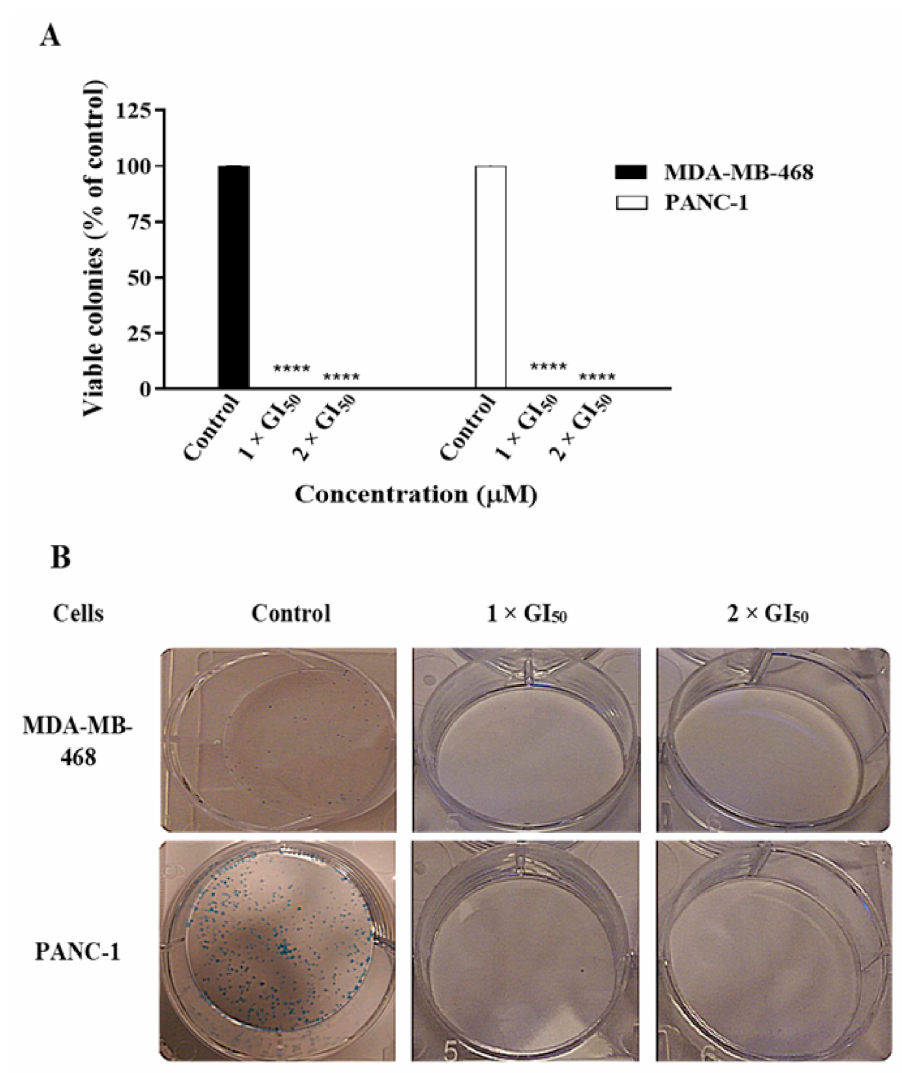
Figure 3. ( A ) Compound 19 completely inhibited the formation of colonies by MDA-MB-468 and PANC-1 cells after 24 h of treatment at concentrations of 1 × GI 50 and 2 × GI 50 . The assay was repeated at least three times. Bars and error bars refer to the mean ± SD. **** p < 0.0001 vs. control. ( B ) Representative images of the assay are shown in the